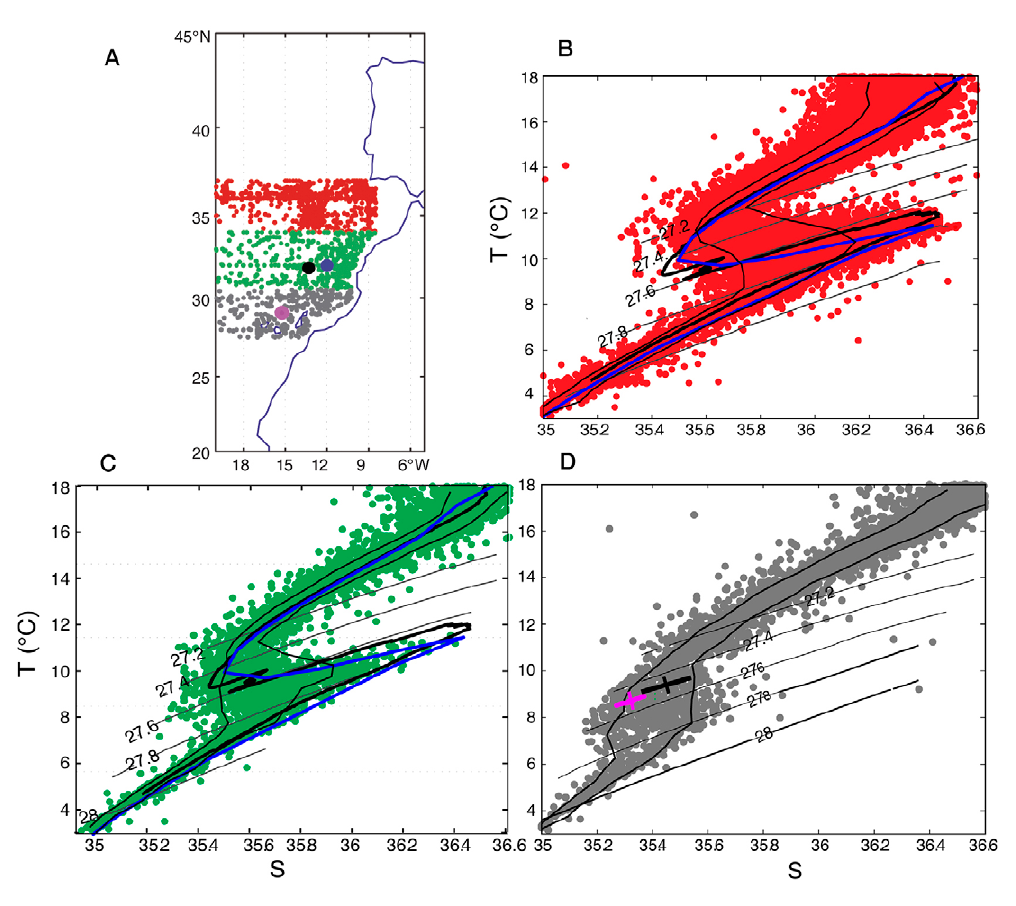
Fig. 3. – The hydrographic and ESTOC data for the Canary Basin are split into three different latitudinal domains, separated at 31 and 34°N, from the coastline to 20°W. A, the red, green and grey dots represent the locations of all NODC profiles in the northern Canary Basin that met our quality control checks; the large black and blue dots show the location of the GC07/M37 meddies, and the magenta dot situates the ESTOC station. B, potential-temperature salinity diagram for the northern domain: the historical hydrographic temperature-salinity data are plotted as red points, with the GC07/M37 meddies shown as thick black/blue lines; the thin black lines show the 15th and 85th percentile for the data, and several neutral-density lines are superimposed as thin grey lines. C, as for panel B but for the middle domain. D, as for panel B but for the southern domain; the black cross shows the mean value and standard deviation for salinity and temperature at 800 m for the entire ESTOC time series, and the magenta cross shows these values during the passage of E96 through the ESTOC station (between December 1995 and February 1996, when the 1200 m salinity exceeded 35.6); the temperatures and salinities recorded at 800 m during the passage of meddy E95 (not shown) are between the mean and E96